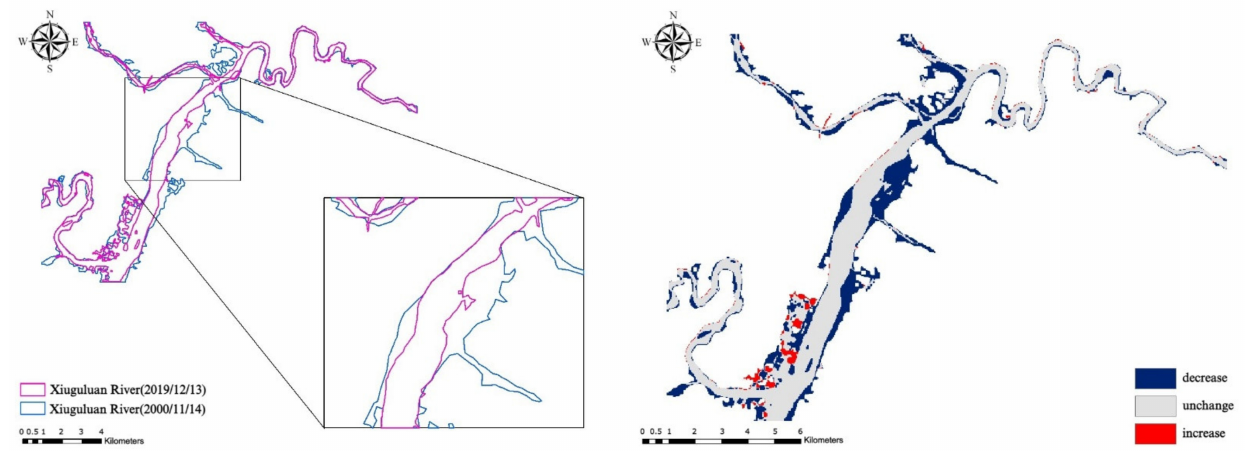
Figure 13. The Xiuguluan River changes between two